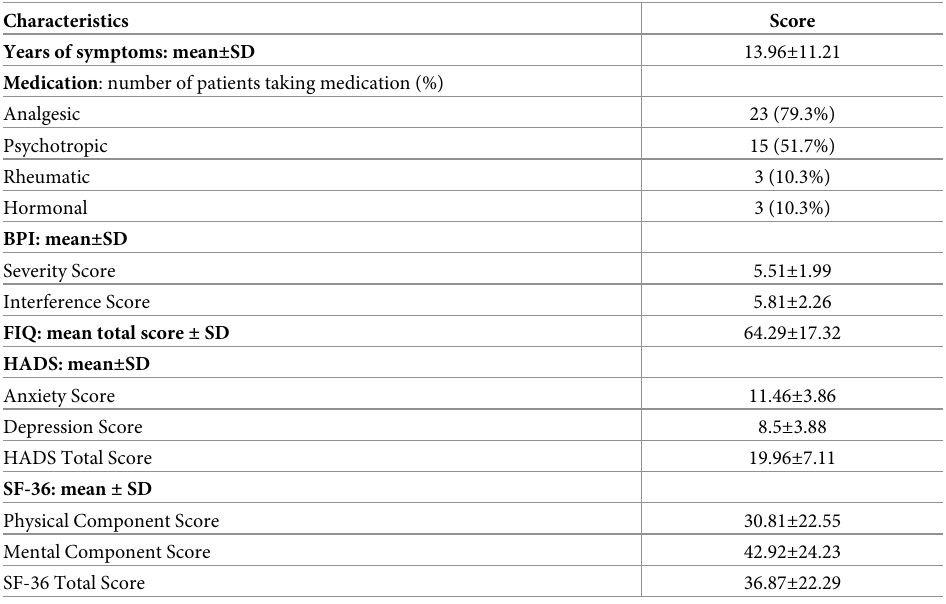
had a mean of 10.75 ± 4.91 years of education. The majority of patients were married (65.5%). Patient characteristics The mean disease duration (since symptoms have emerged) of the fibromyalgia patients was 13.96 ± 11.21 years (range 2–46 years). Details of the 6 clinical questionnaires and the medica- tion used can be found in Table 2. Most of the patients used analgesics (79.3%), and slightly more than half were using psychotropics (51.7%). Table 2. Clinical characteristics of fibromyalgia patients (n =